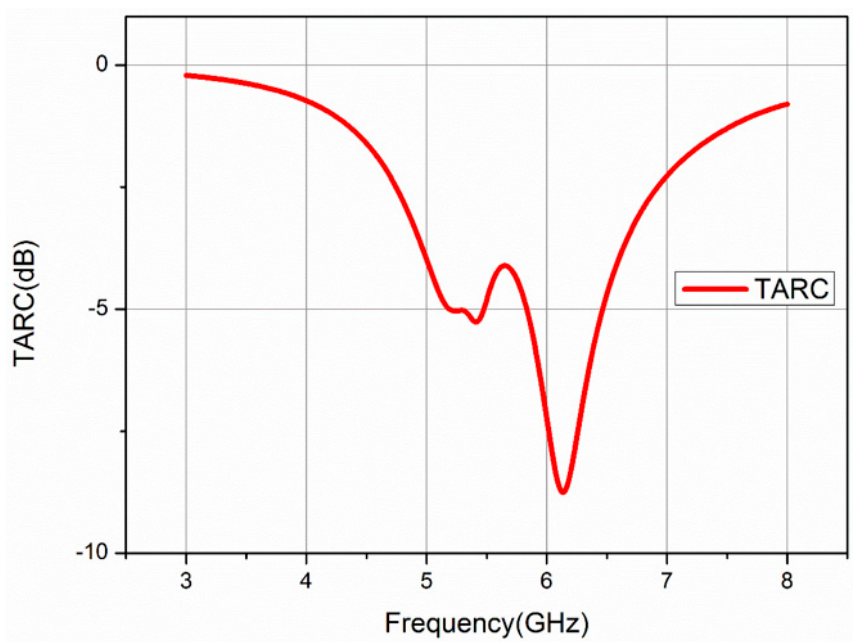
Figure 12. Simulated total active reflective coefficient.